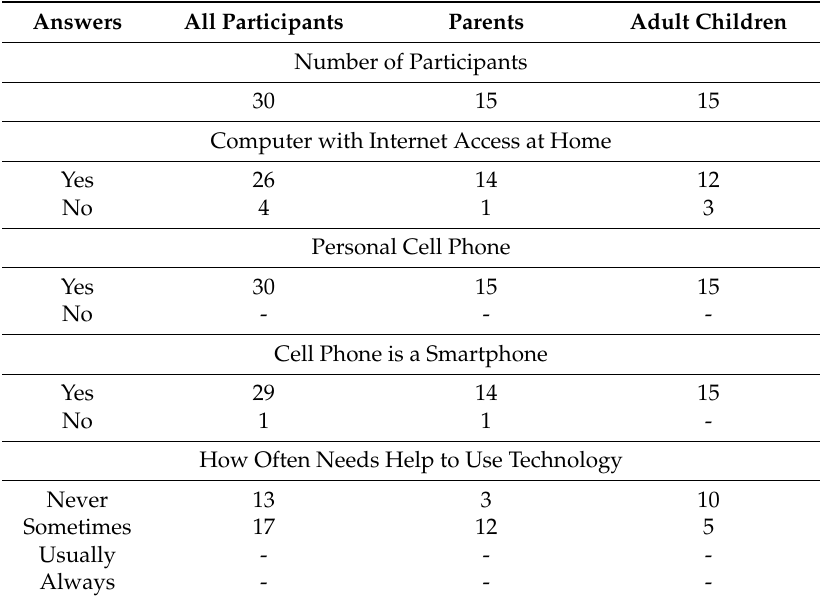
Table 3. Access to